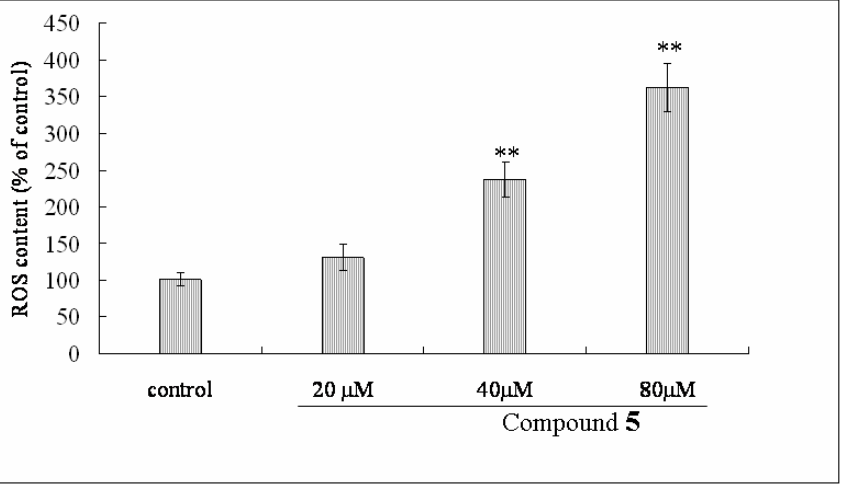
Figure 6. After the treatment of Bel-7402 cells with different concentrations of compound 1 for 48 h, ROS production were assayed by the fl uorescence intensity of DCF with the enzyme-immunoassay instrument at an excitation wavelength of 485 nm and an emission wavelength of 535 nm. The data were represented as mean ± standard S.D for six independent experiments. * P < 0.05 and ** P < 0.01 vs.